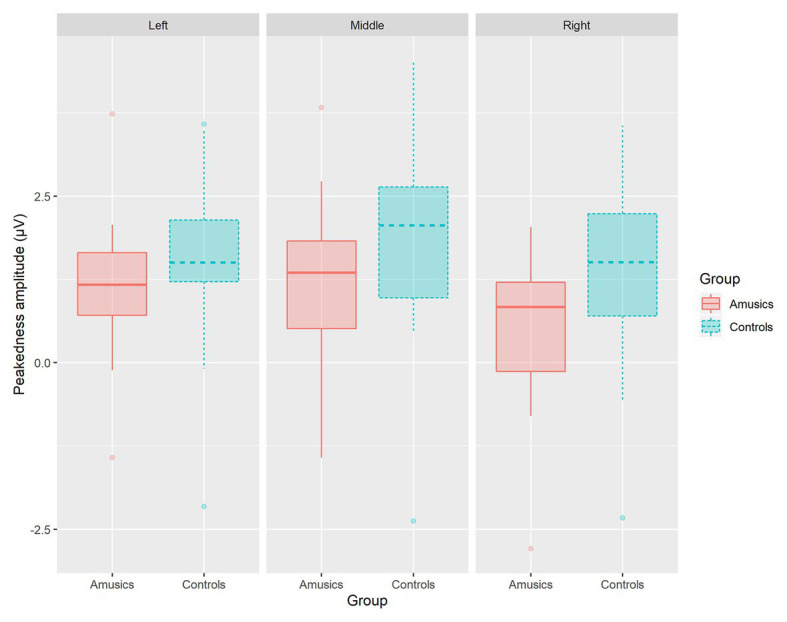
The boxplot of peakedness amplitude (the amplitude of between-category deviants minus that of within-category deviants) between the controls and amusics in the speech context.